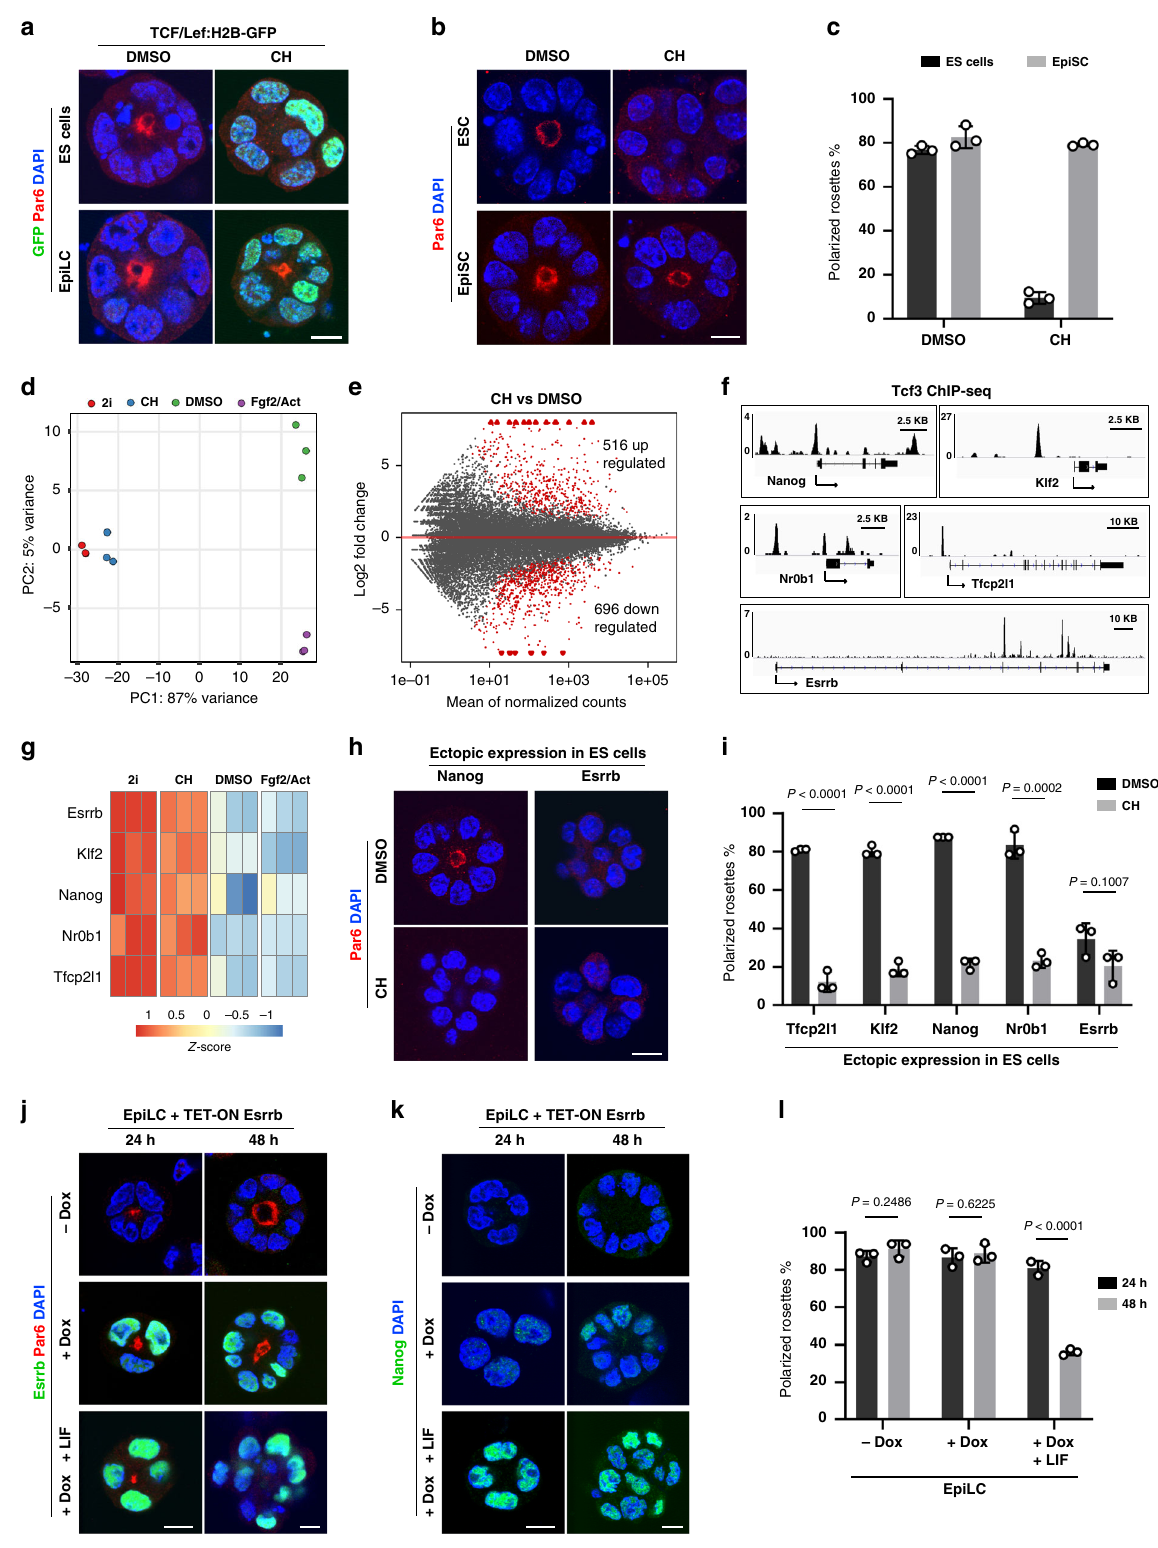
self-renewal. In addition, focal adhesion and intercellular tight junction gene sets were enriched in Esrrb knockout cells, indicating ongoing epithelialization (Fig. 4f and Supplementary Fig. 4b). In order to identify the downstream effectors of Esrrb that control the establishment of apical – basal polarity in a